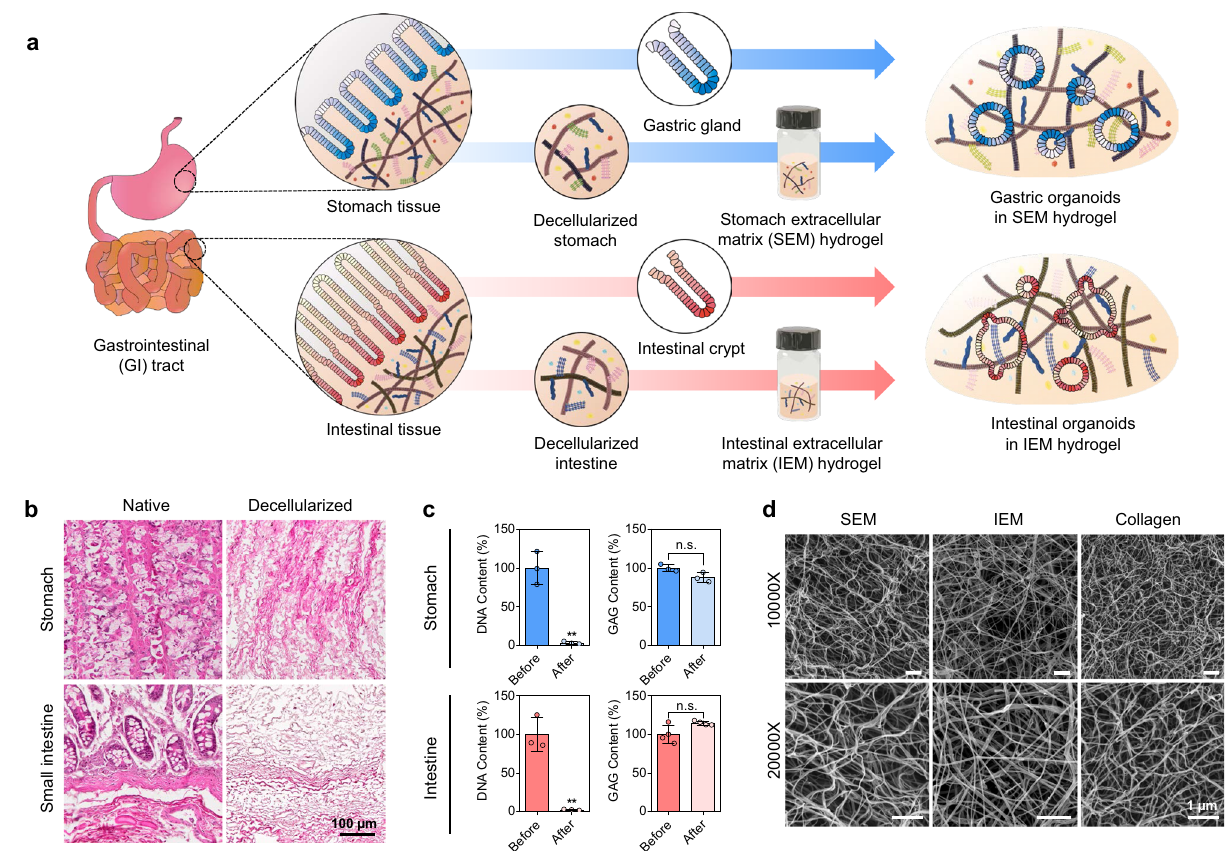
Fig. 1 Preparation and characterization of GI tissue-derived ECM hydrogels for GI organoid culture. a Schematic illustration of the generation of GI organoids using ECM hydrogels (SEM and IEM) derived from the decellularized GI tract. b Hematoxylin and eosin (H&E) staining of the porcine stomach and intestinal tissues before and after decellularization (scale bar = 100 µ m, independent experiments = 2). c DNA and glycosaminoglycans (GAG) content of porcine stomach and intestinal tissues before and after decellularization (Before versus After, ** p = 0.0014 for DNA content of stomach; Before versus After, ** p = 0.0015 for DNA content of intestine; N = 3 for SEM and N = 4 for IEM, independent experiments = 2). Non-signi fi cant statistical difference was indicated as n.s. ( p > 0.05). d Scanning electron microscopic observation that shows the internal ultrastructure of GI tissue-derived ECM hydrogels (scale bars = 1 µ m, independent experiment = 1). The data in ( c ) are presented as mean ± S.D. Statistical signi fi cance was analyzed using an unpaired, two-sided student ’ s t